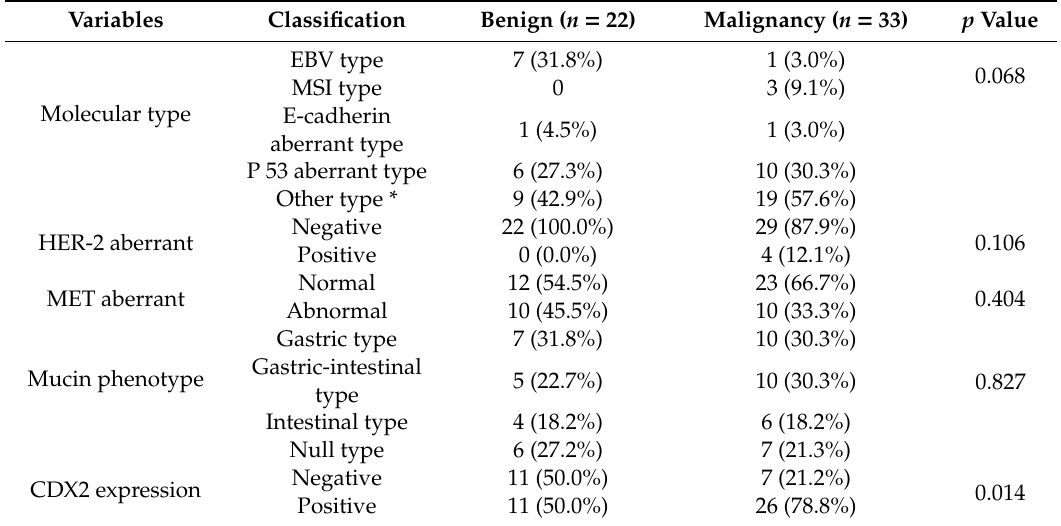
Table 5. Classification based on immunohistochemistry and in situ